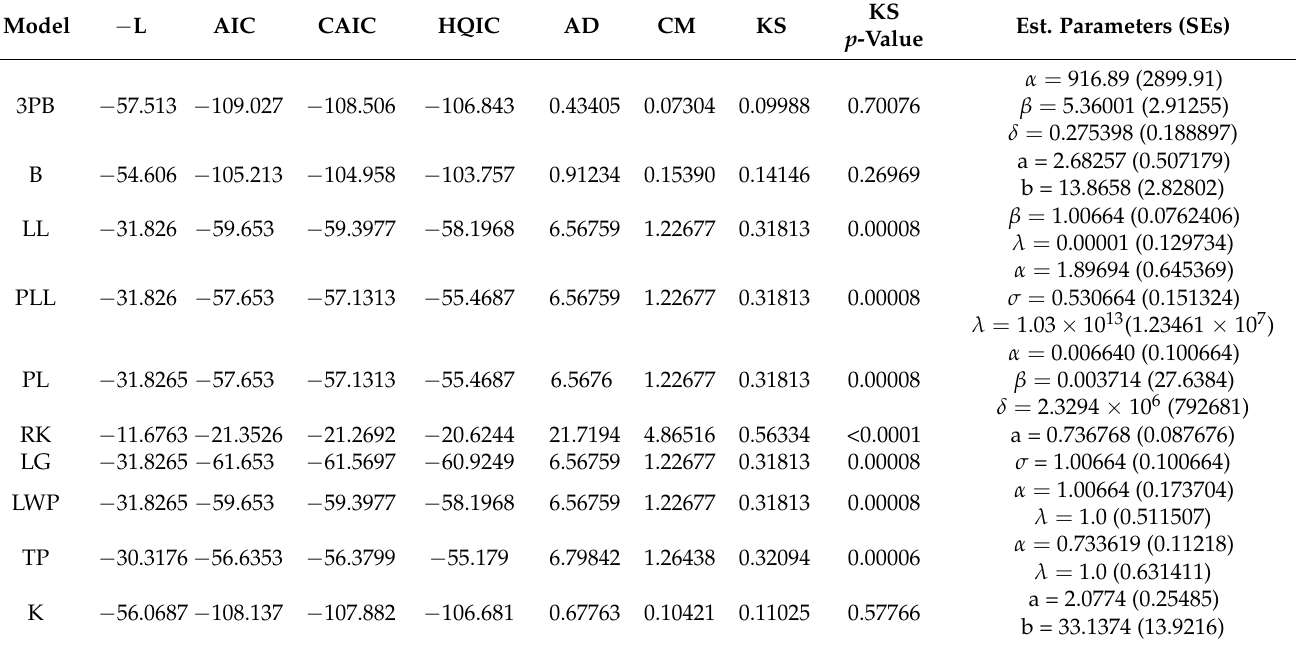
Table 4. Numerical information criteria values with the goodness-of-fit measures for the burr data set.